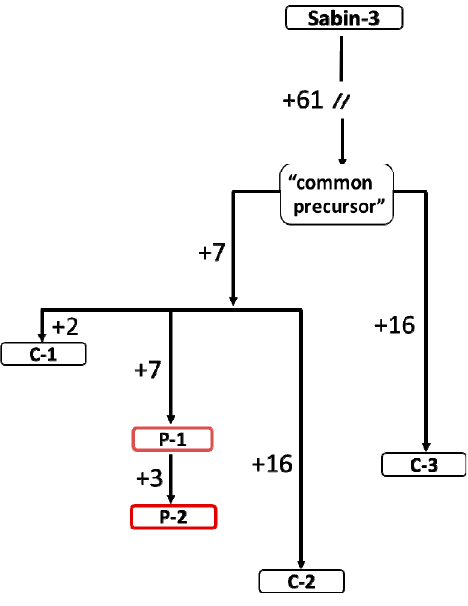
Figure 1. A hypothetical evolutionary pathway of the polioviruses isolated in Syzran in 2014. The identifiers of the isolates’ genomes are given in the frames. The numbers of the nucleotide mutations acquired by the isolates are indicated to the left of the arrows.